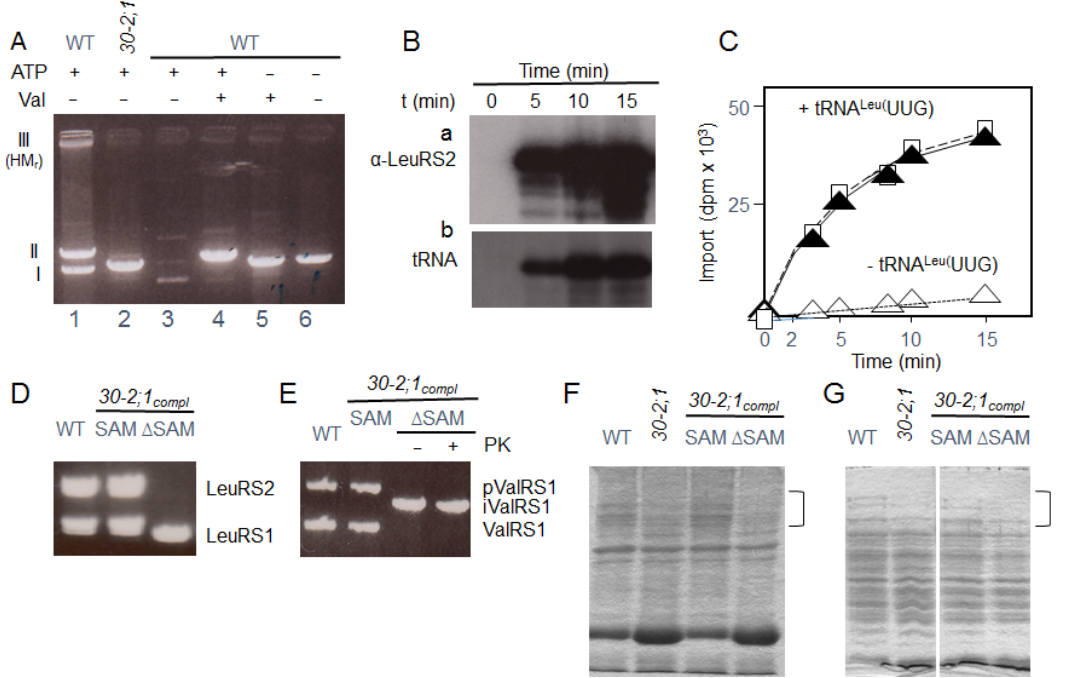
Figure 5. LeuRS2-tRNA co-import and effect of the sterile alpha motif (SAM) domain of HP30-2. ( A ) Agarose gel electrophoresis to detect LeuRS2-(His) 6 -bound tRNA in mitochondrial translocation intermediates in the wild-type (WT) and Athp30-2;1 (SALK_136524) T-DNA insertion mutant at the indicated combinations of ATP and valinomycin. Incubations were carried out at 8 ◦ C. Note the lack of any of these bands in wild-type mitochondria that had been pretreated with proteinase K (Lane 3). ( B ) Time course of LeuRS-(His) 6 and tRNA uptake into the matrix of wild-type mitochondria. Incubations were carried out at 23 ◦ C and the amounts of LeuRS2-(His) 6 and tRNA determined by successive steps of western and northern blotting, respectively, carried out on the same nitrocellulose membrane. ( C ) as B, but showing kinetic LeuRS2 uptake data for tRNA Leu (UUG)-containing assays (black triangles) and tRNA Leu (UUG)-free assays (white triangles). For comparison, tRNA Leu (UUG) uptake data were included (white squares). D and E, as B, but showing the amount of LeuRS1-tRNA and LeuRS2-tRNA ( D ) versus ValRS1-tRNA ( E ) imported into mitochondria of WT plants and complemented hp30-2;1 plants ( hp30-2;1 compl ) expressing either the full-length HP30-2 cDNA (SAM) or cDNA lacking the coding sequence of the SAM domain ( ∆ SAM). Note the accumulation of intermediate-sized ValRS1 (iValRS1) in mitochondria of hp30-2;1 plants expressing the SAM-less variant of HP30-2. PK, proteinase K. F and G, patterns of total mitochondrial proteins ( F ) and soluble matrix proteins ( G ) in WT plants and WT plants expressing either the full-length HP30-2 (SAM) or HP30-2 ∆ SAM